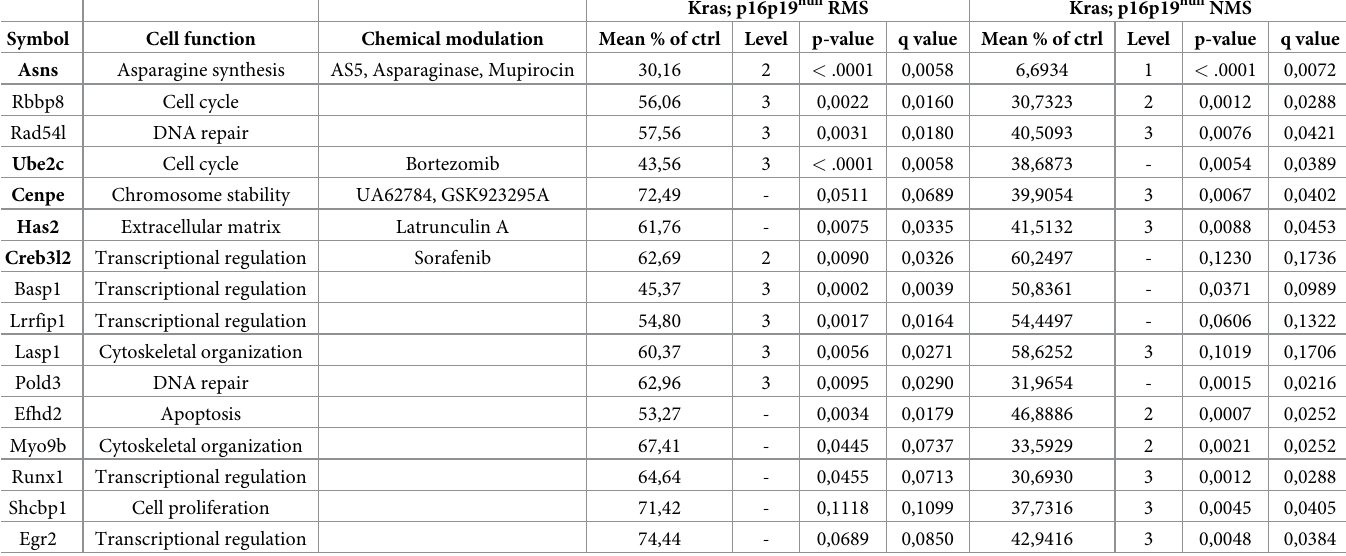
Table 1. Proliferation-relevant sarcoma genes. Transcriptional profiling of genetically engineered, KRAS-induced mouse rhabdomyosarcomas (RMS) and non-myo- genic sarcomas (NMS) identified 141 sarcoma-relevant genes; their function was evaluated using a customized shRBA screen. Sixteen of the 141 sarcoma-relevant genes scored as „hits”in RMS and/ or NMS (p < 0,01, q > 0,05, at least 3 of 5 shRNAs with FDR < 30%) and are listed here. These 16 hits include 5 potentially druggable targets, i.e. Asns, Cenpe, Crebl2, HAs2 and